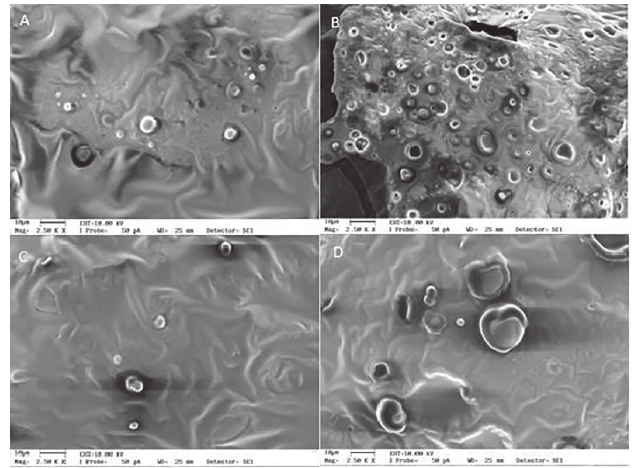
FIGURE 3 - Efficiency of the formation of A. phalerata Mart. pulp oil microcapsules: (A) core vs. speed at 60 °C; (B) core vs temperature at 18000 rpm; (C) temperature vs. speed with 10